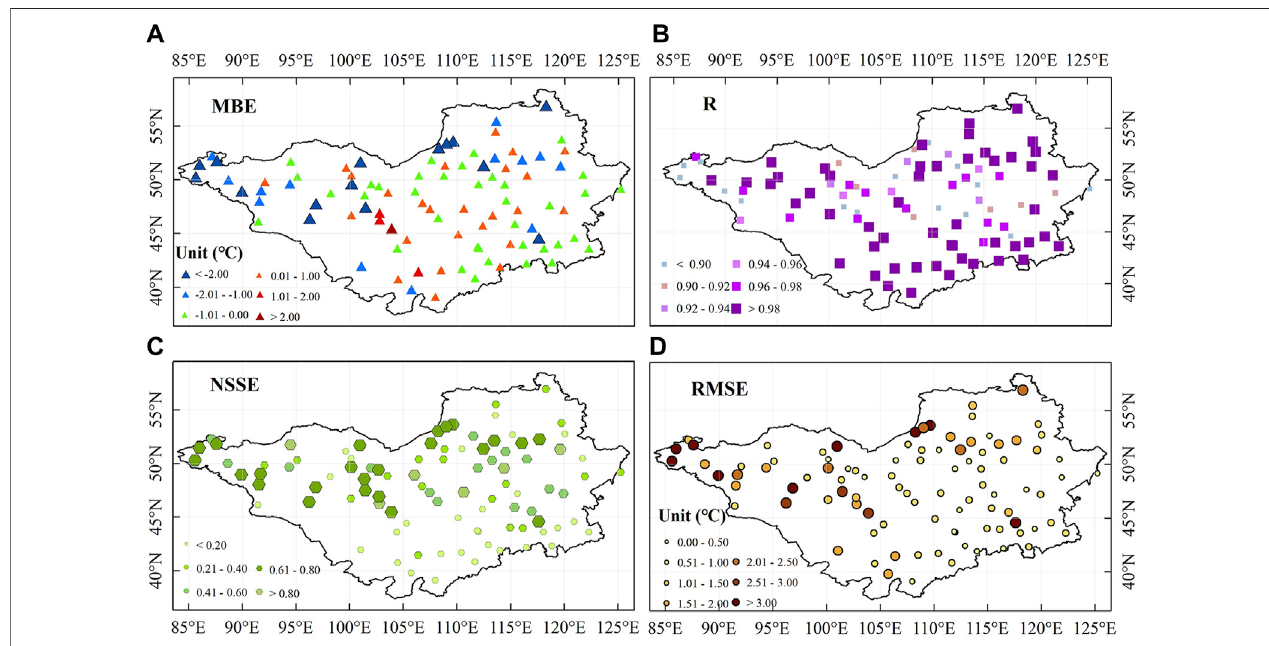
FIGURE 3 | Spatial distribution of four error indicators, including MBE (A) , R (B) , NSSE (C) , and RMSE (D) .